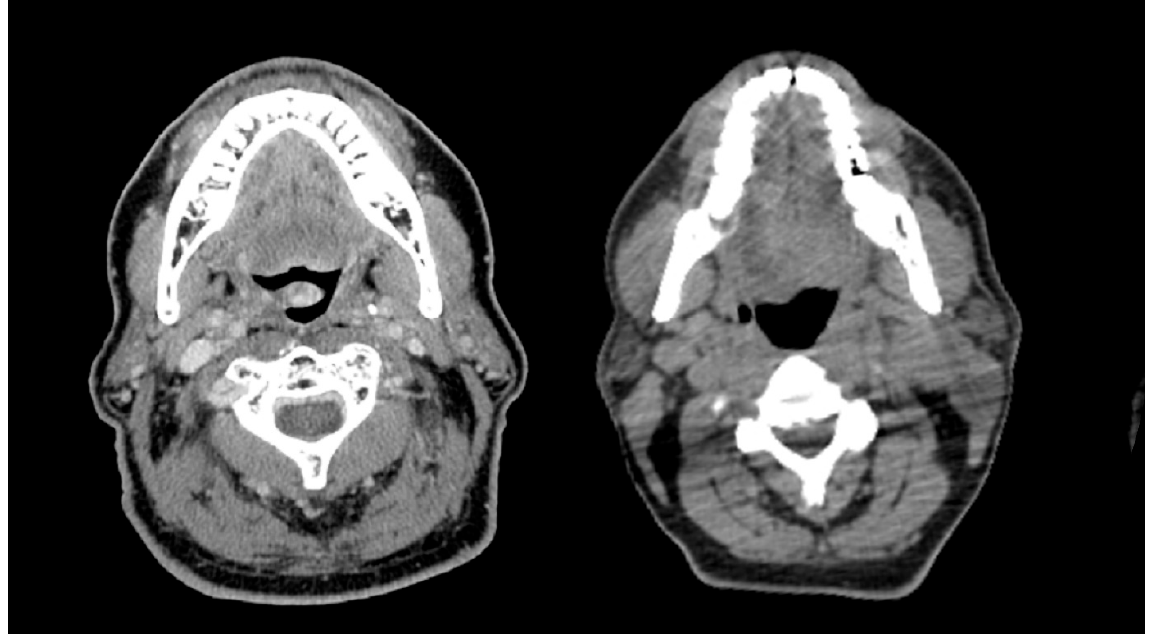
Figure 2. A comparison of older and younger patients with and without sarcopenia with similar BMI. The left panel represents a 70-year-old man with HPV-positive oropharynx cancer with sarcopenia (BMI 27.6 kg/m²) experiencing 10 days of radiation treatment delay, while the right panel represents a 56-year-old man with HPV-positive oropharynx cancer without sarcopenia (BMI 26.7 kg/m²) having no days of radiation treatment delay.